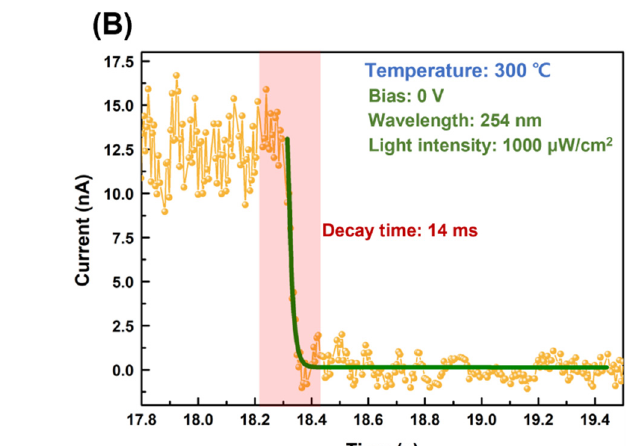
Figure 6. ( A ) Illustration of the as-fabricated CuO/ β -Ga 2 O 3 heterojunction photodetector under 254 nm solar-blind UV light; ( B ) continuous time-dependent photocurrent density characteristics of CuO/ β -Ga 2 O 3 heterojunction photodetectors at zero bias under 254 nm solar-blind UV light with 1000 μ W/cm 2 light intensity; ( C ) time-dependent photocurrent density characteristics of photode- tector postannealed at 300 °C under 254 nm solar-blind UV light with different light intensities; ( D ) postannealing temperature-dependent EQE under 254 nm solar-blind UV light with intensity of 1000 μ W/cm 2 . Variation of ( E ) responsivity and ( F ) detectivity of photodetector with varying light intensity at zero bias.